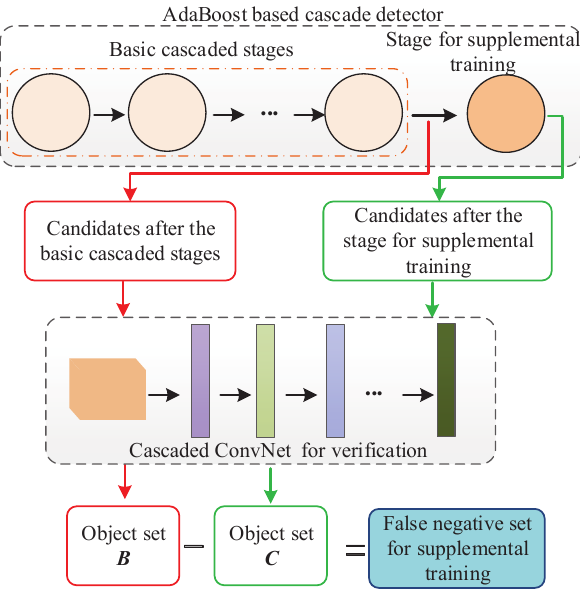
Figure 3. The supplemental training process.